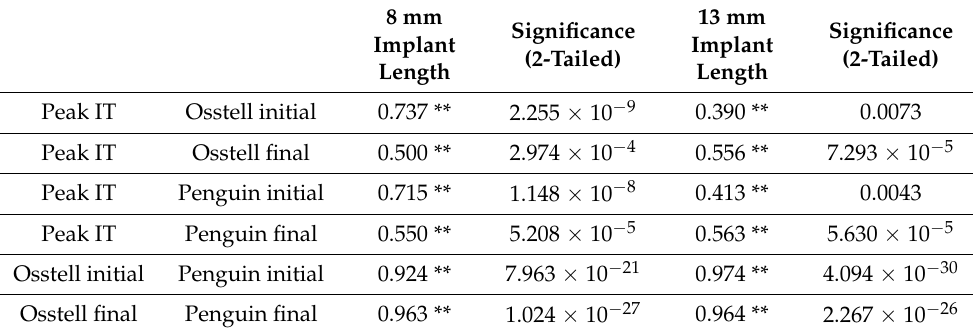
Table 6. Correlation coefficient between the different device measurements using Spearman’s rho correlation coefficient comparing the effect of implant length on the correlation (IT = insertion torque). ** The correlation is significant at the 0.01 level (2-tailed).